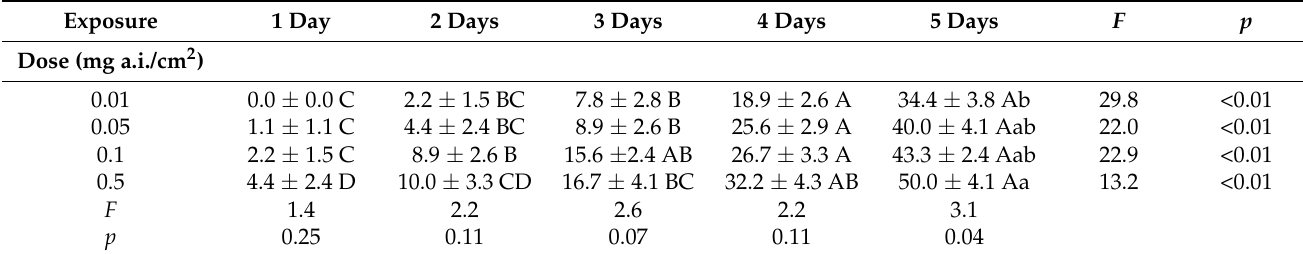
Table 5. Mean immediate mortality (% ± SE) of Rhyzopertha dominica adults exposed on concrete treated with chlorantranilip- role at four doses (0.01, 0.05, 0.1, and 0.5 mg a.i./cm 2 ), for 1, 2, 3, 4, and 5 days. Within each row, means followed by the same uppercase letter are not significantly different (in all cases DF = 4, 44, Tukey–Kramer HSD test at p = 0.05). Within each column, means that are followed by the same lower-case letter are not significantly different (in all cases DF = 3, 35, Tukey–Kramer HSD test at p = 0.05). Where no letters exist, no significant differences were recorded.